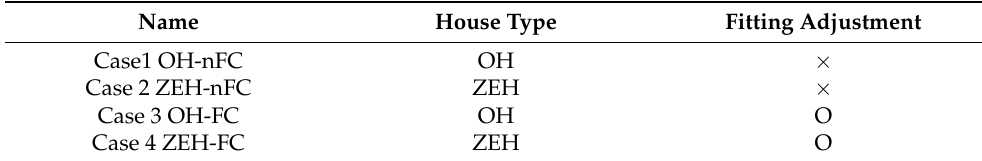
Table 6. Calculation